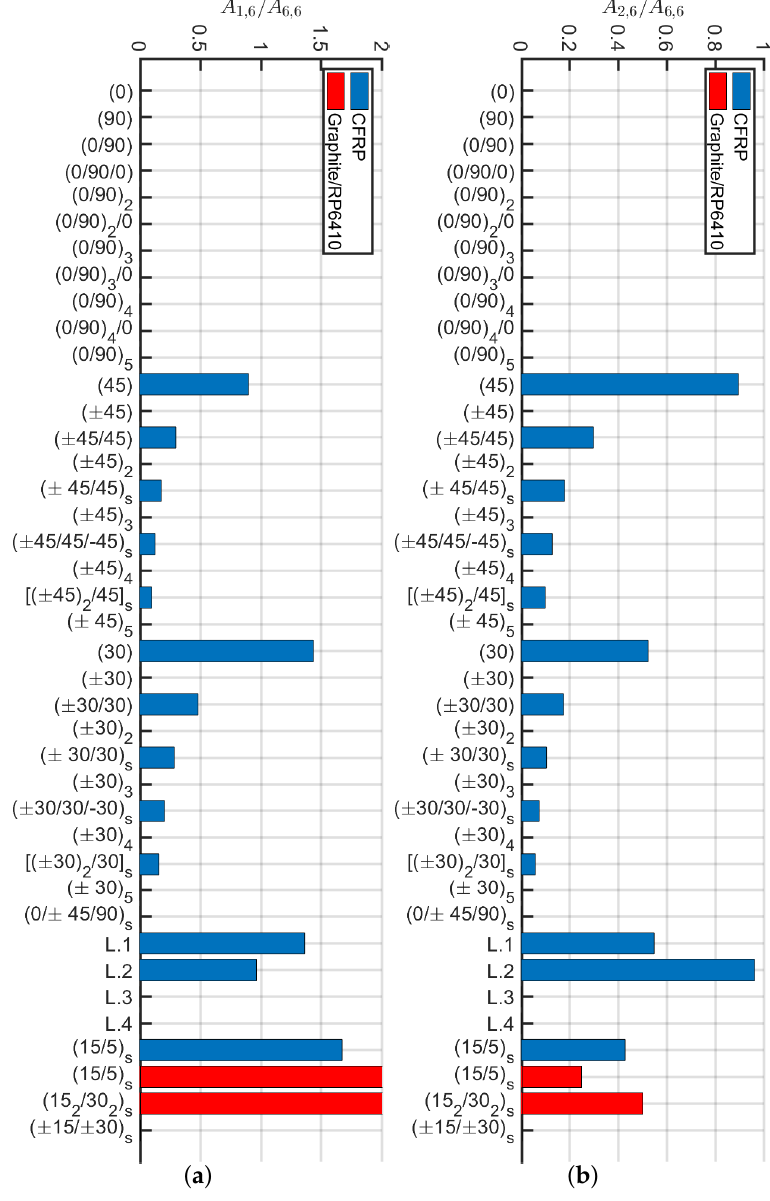
Figure 19. Ratios ( a ) A 1,6 / A 6,6 and ( b ) A 2,6 / A 6,6 for different